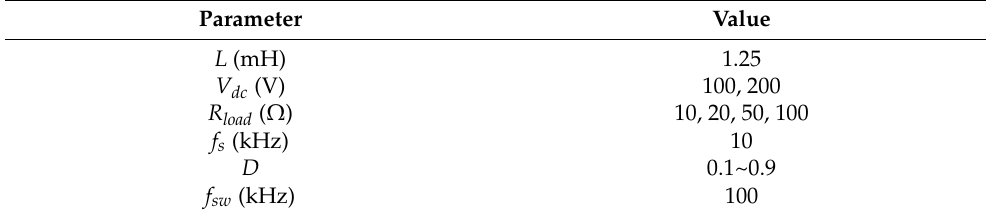
Table 5. Related parameters in the simulation and